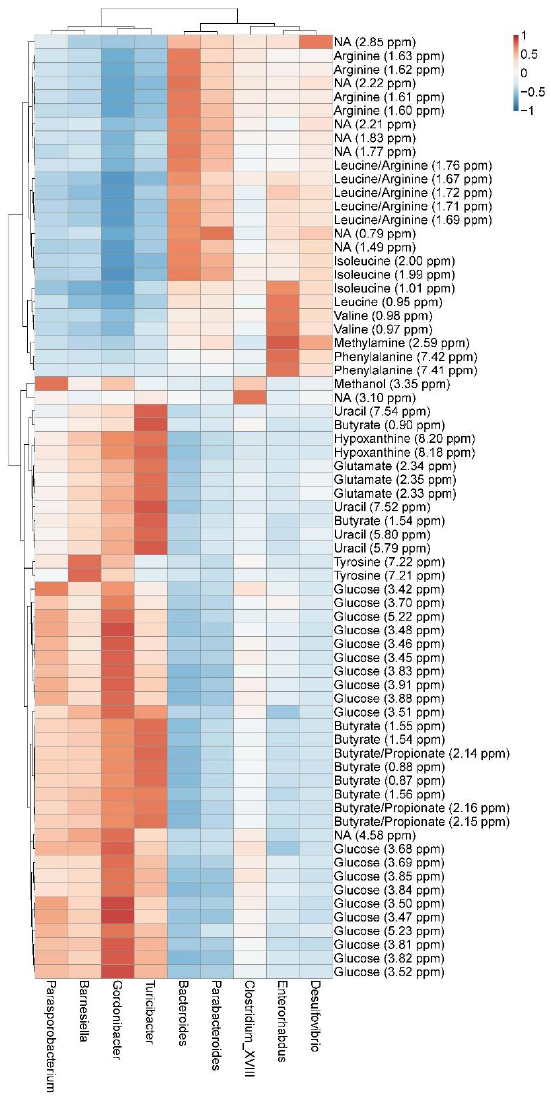
Figure 6. Heatmap of Pearson correlations between colon metabolite concentration and relative abundance of bacterial genera. The gut microbiota composition was analyzed by 16S rRNA sequenc- ing while the metabolic pattern was analyzed by 1 H NMR spectroscopy. Only metabolites and bac- teria genera with at a correlation coefficient >0.7 are shown. The color intensity from blue to red corresponds to the correlation coefficient from −1 to 1.